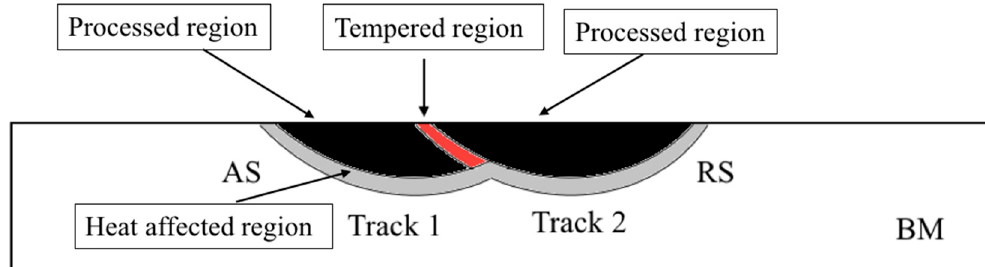
Figure 6. Schematic of back-tempering in the multi-pass FSPed 420.